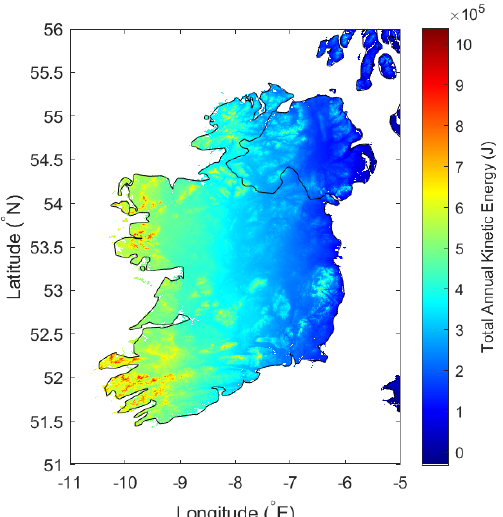
Figure 26. A total annual kinetic energy map of the island of Ireland, generated using Equation (6), using topographical data obtained from NASA and processed with the READHGT function